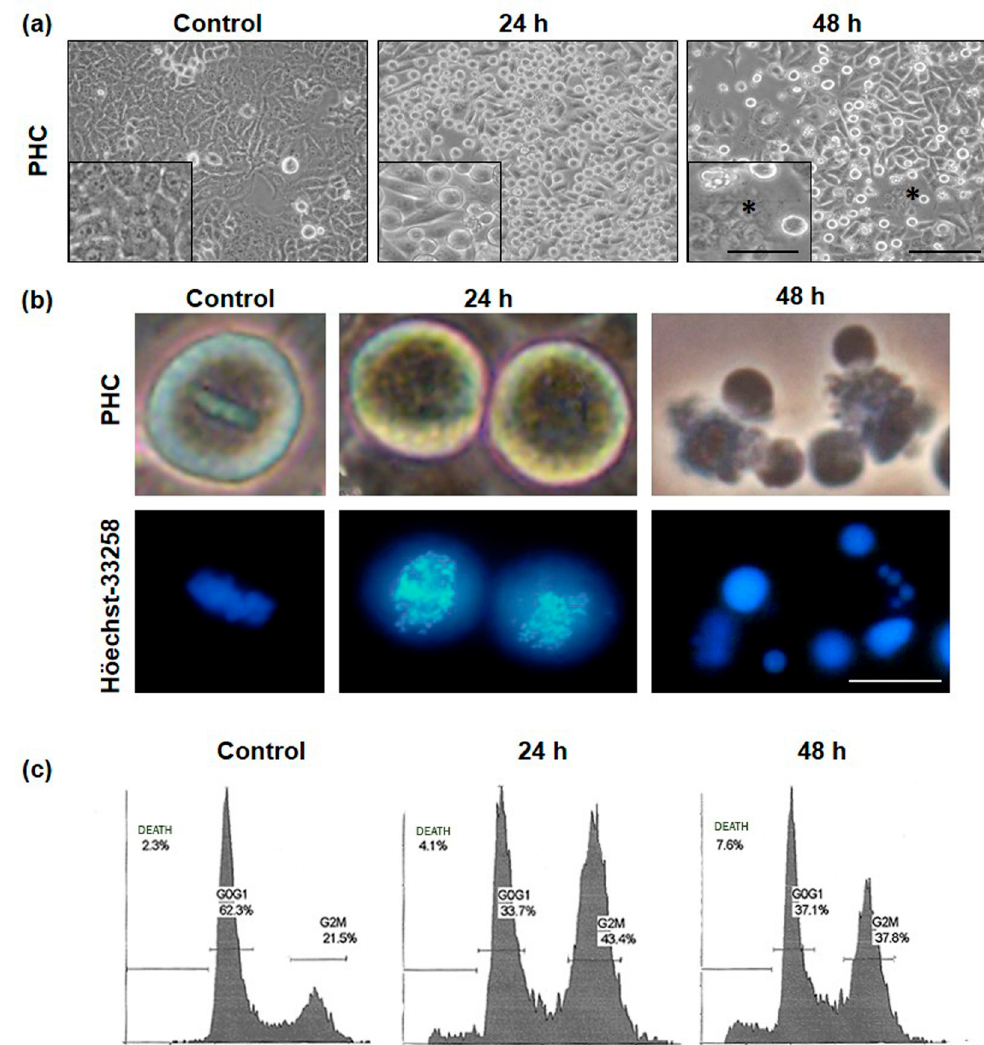
Figure 3. Cellular and nuclear morphology in control cells and after PDT (photodynamic therapy). Cells were observed by phase contrast microscopy (PHC). ( a ) Control HeLa cells presented an epithelial aspect; after 24 h treatment a high number of rounded mitotic cells could be seen in the cultures; after 48 h treatment, cells with multinucleated morphology appeared in the cultures (asterisk) and apoptotic morphologies. Scale bar: 100 µ m; inserts 10 µ m. ( b ) PHC and nuclei morphology observed by fluorescence microscopy after Höechst-33258 staining, after 24 h PDT mainly metaphases, normal and abnormal with chromosome fragmentation and after 48 h PDT apoptotic morphology. ( c ) Cell cycle distribution outlines in each cell cycle phase 0, 24 and 48 h after PDT. Scale bar: 20 µm.